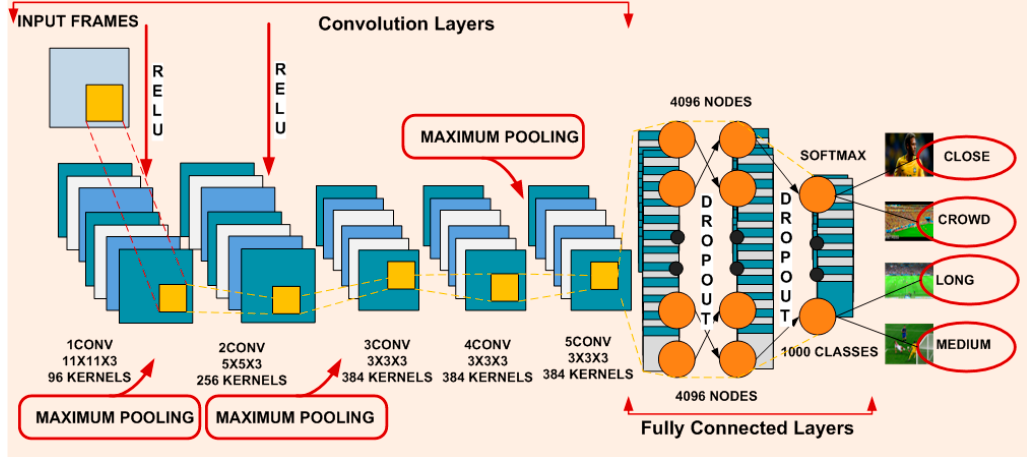
Figure 2. AlexNet convolution neural network architecture of the proposed framework.